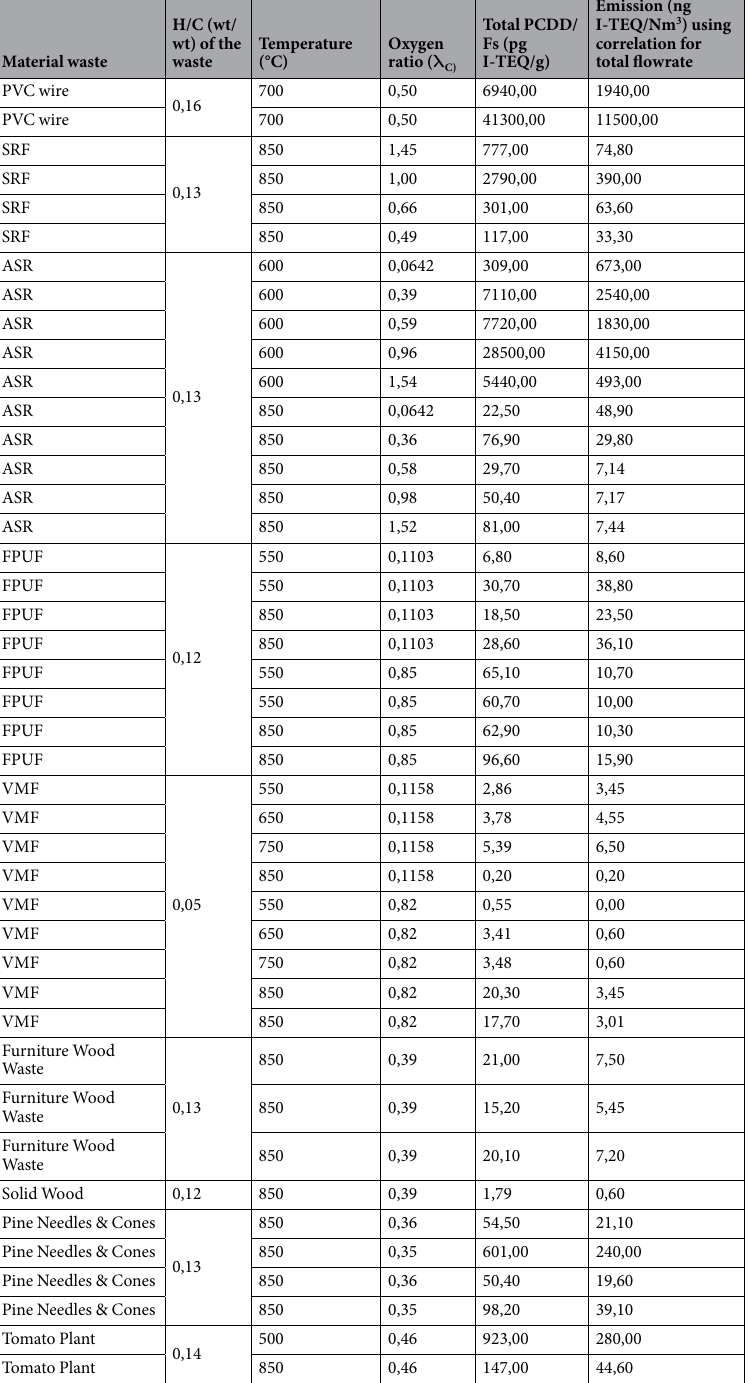
Table 2. Different wastes studied, the C/H ratio of the starting waste material, experimental conditions (temperature and oxygen ratio), and comparison of the PCDD/F emissions between the data obtained from the laboratory experiments (pg I-TEQ/g) and the data calculated using the total flowrate correlation (ng I-TEQ/Nm 3 ). MBM: meat and bone meal. PVC: poly vinyl chloride. SRF: solid recovered fuel. FPUF: